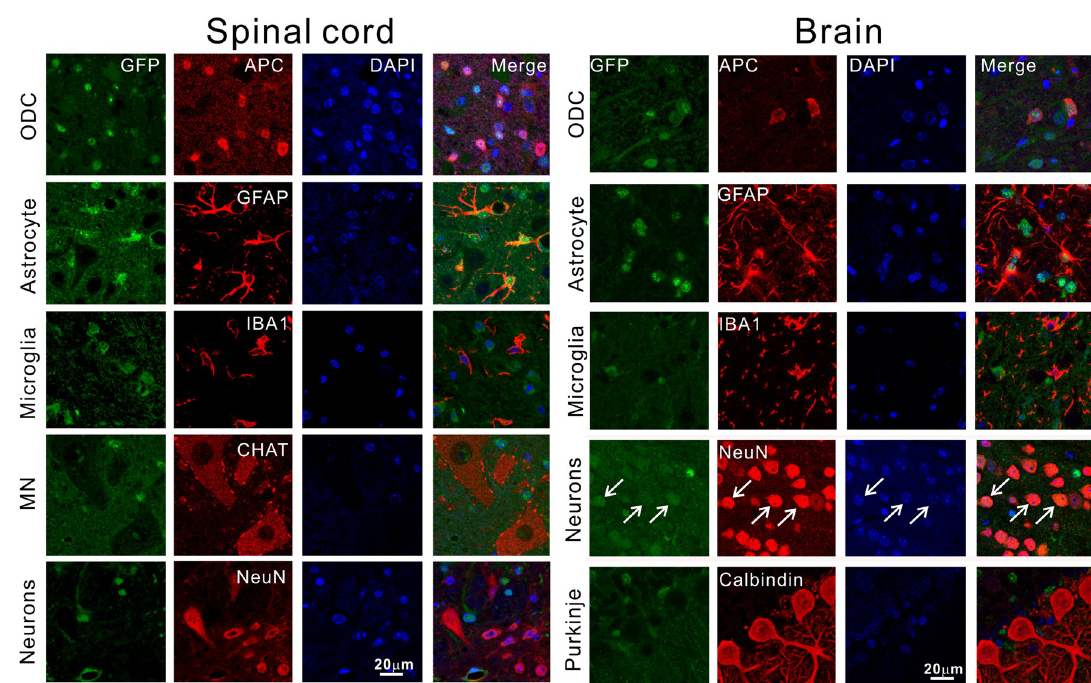
Fig 3. The Tg mice expressed transgenes in multiple different cell types in the spinal cord and the brain. In the spinal cord, the expression was relatively strong in oligodendrocytes (ODC) and astrocytes but weak in microglia and neurons, including motor neurons. In the frontal cortex (top four rows under the brain label), the transgenes are expressed strongly in ODC, astrocytes, and neurons (arrows) but weakly in microglia. Sections were double immunostained for GFP and various cellular marks as indicated. The transgenes were weakly expressed in Purkinje cells compared with the surrounding neuropils in the cerebellum. All panels are in the same magnification. All animals used are pre-symptomatic and less than 100 days old.